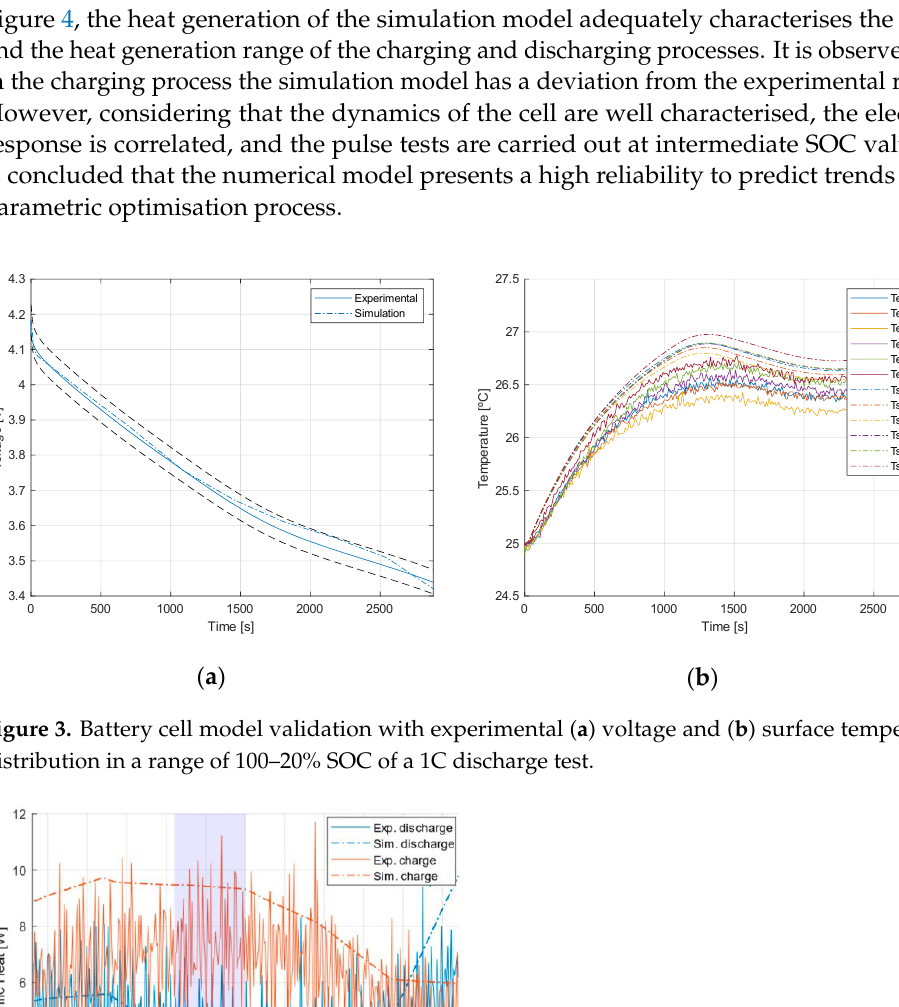
Figure 3. Battery cell model validation with experimental ( a ) voltage and ( b ) surface temperature distribution in a range of 100–20% SOC of a 1C discharge test.